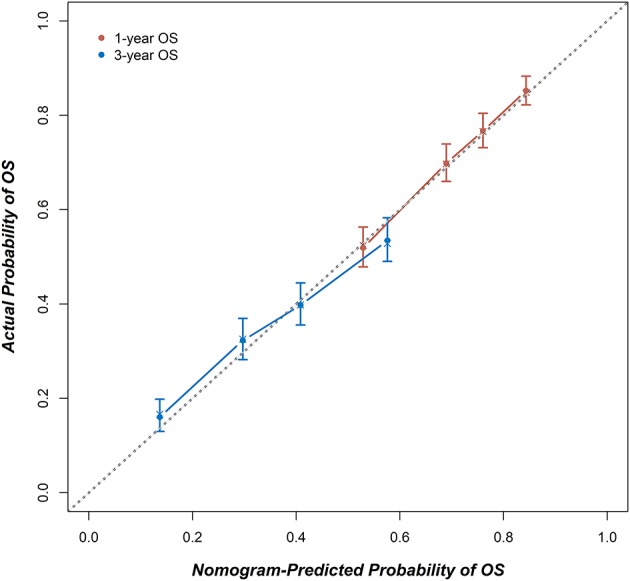
The calibration curves for predicting 1- and 3-year OS. X-axis: The OS probability predicted by the nomogram; y-axis: the actual OS probability. A plot along the 45-degree dotted line indicates a perfect calibration model, where the predicted probabilities and actual outcomes are identical.